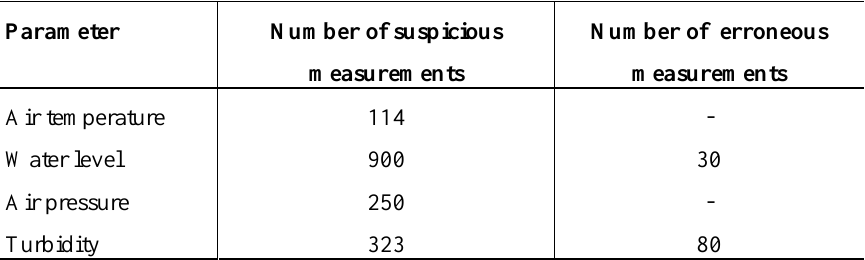
Table 4. Number of the suspicious and erroneous measurements by range test during